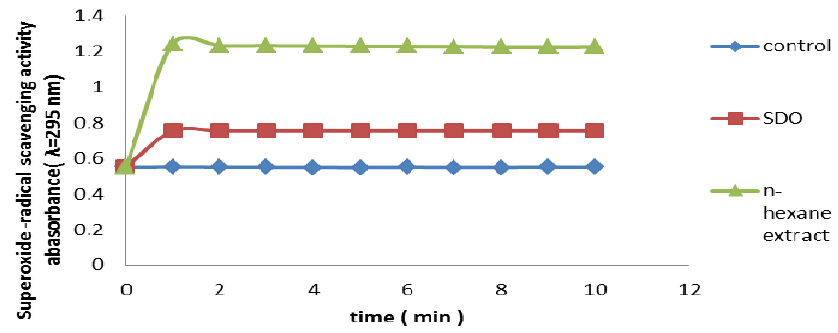
Figure 8. Superoxide radical scavenging activity of hexane extract from leaves of Piper Auritum. α -tocopherol was used as reference antioxidant and SOD as control. Values are mean ± SEM. (n =